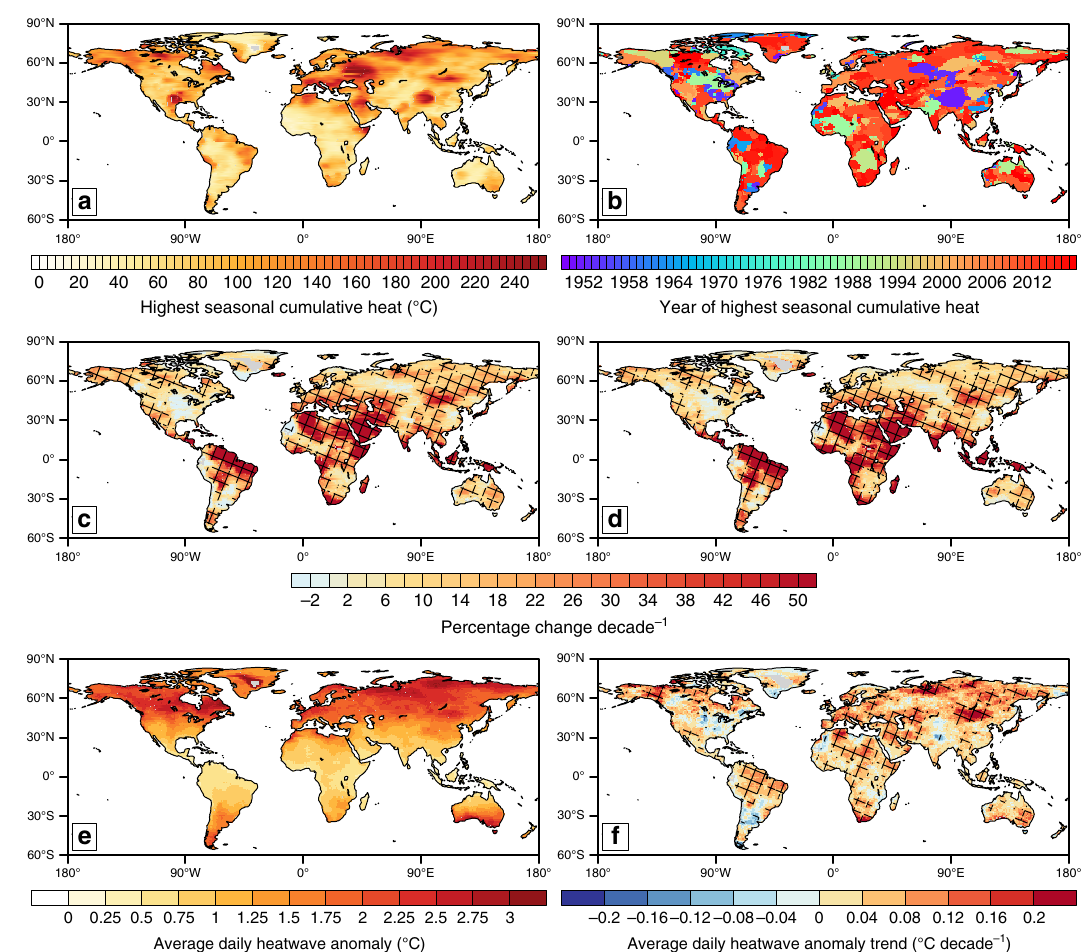
Fig. 2 Global maps of cumulative heat statistics. The highest seasonal cumulative heat (sum of anomalies relative to the calendar-day 90th percentile) ( a ); the year in which this value occurs ( b ); decadal trends in the percentage change of cumulative heat ( c ) and heatwave days ( d ); the average anomaly of a heatwave day ( e ) and the respective decadal trend ( f ). All values are calculated for the global observational dataset Berkeley Earth, for 1950 −